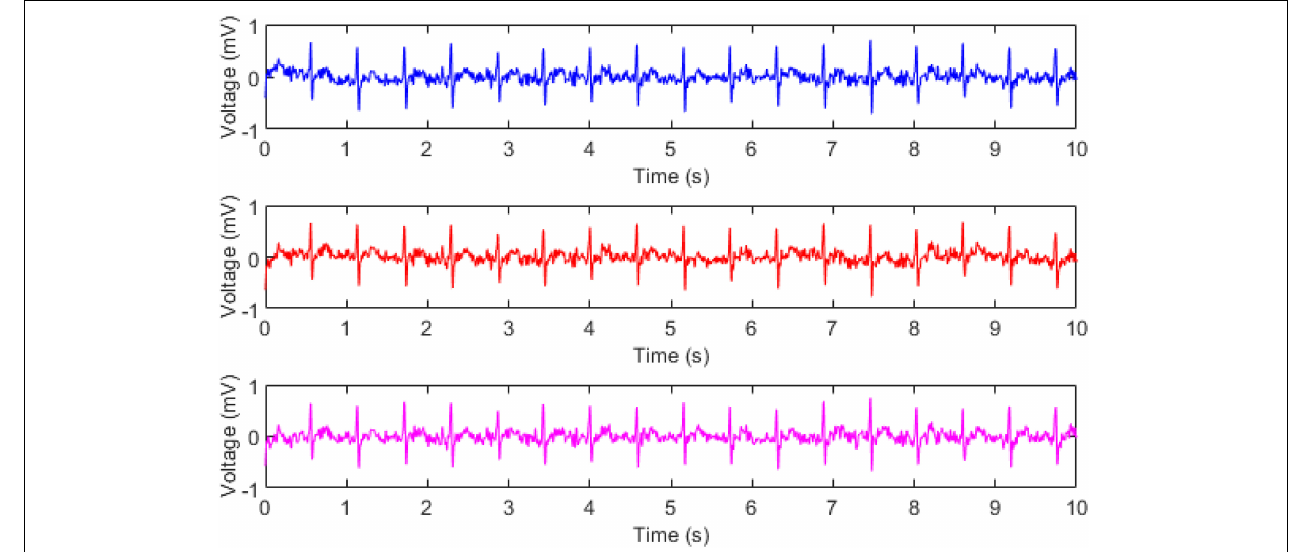
FIGURE 4 | The ECG recorded by wet electrode (blue), proposed electrode (red), dry electrode (pink) at the speed of 2